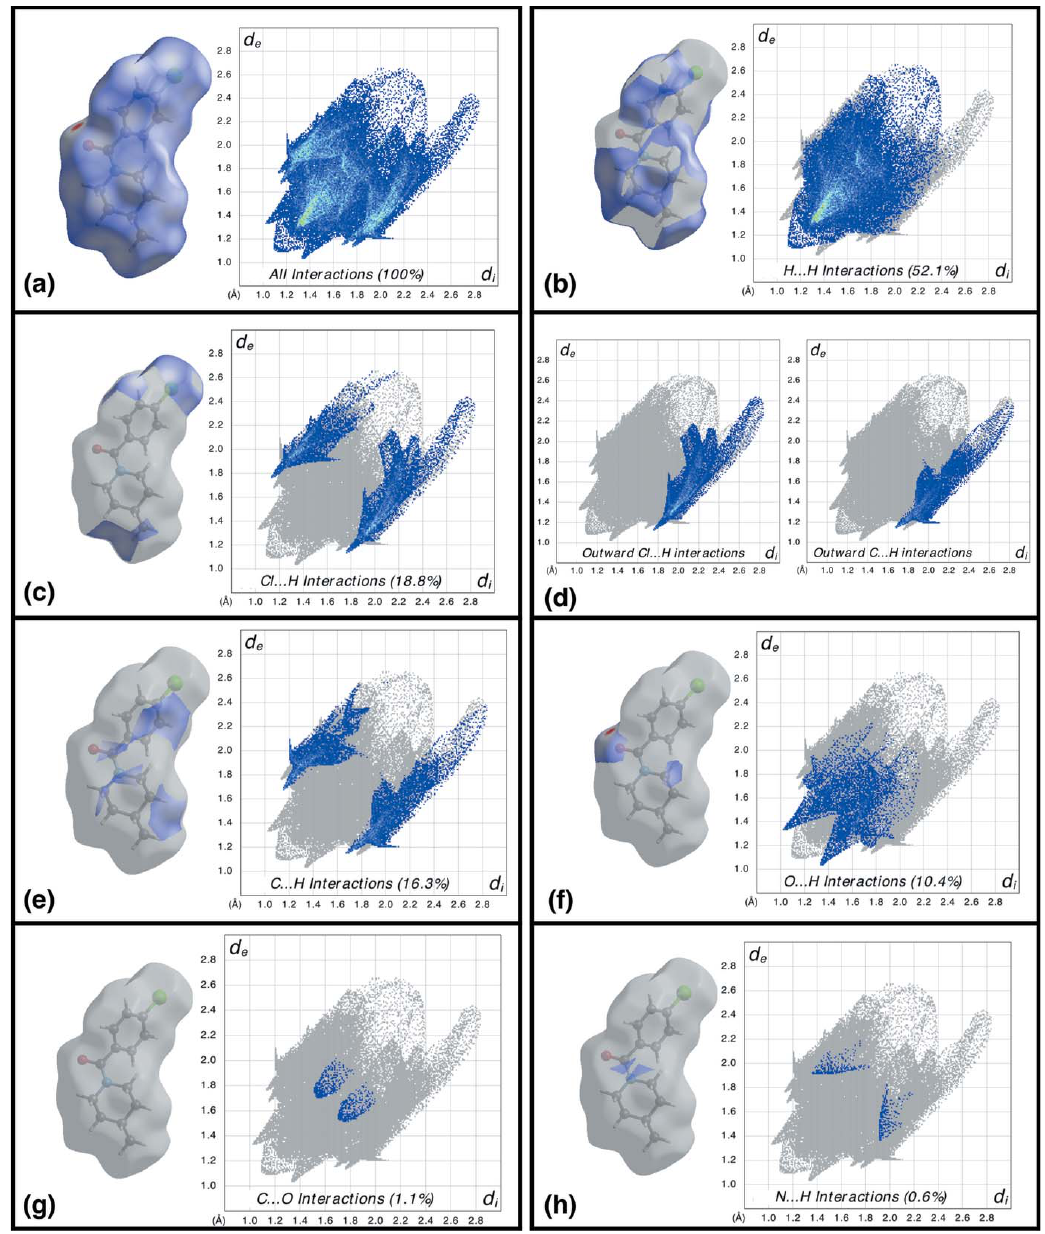
Figure 4 Two-dimensional fingerprint plots illustrating the percentage contributions of contacts within the crystal: ( a ) all intermolecular interactions, ( b ) H (cid:3)(cid:3)(cid:3) H contacts, ( c ) H (cid:3)(cid:3)(cid:3) Cl/Cl (cid:3)(cid:3)(cid:3) H contacts, ( d ) Outward Cl (cid:3)(cid:3)(cid:3) H and C (cid:3)(cid:3)(cid:3) H interactions, ( e ) H (cid:3)(cid:3)(cid:3) C/C (cid:3)(cid:3)(cid:3) H contacts, ( f ) O (cid:3)(cid:3)(cid:3) H/H (cid:3)(cid:3)(cid:3) O contacts, ( g ) C (cid:3)(cid:3)(cid:3) O/O (cid:3)(cid:3)(cid:3) C contacts and ( h ) N (cid:3)(cid:3)(cid:3) H/H (cid:3)(cid:3)(cid:3) N contacts. The Hirshfeld surfaces mapped over d norm are displayed in grey, with the relevant surface patches associated with the specific contacts highlighted in